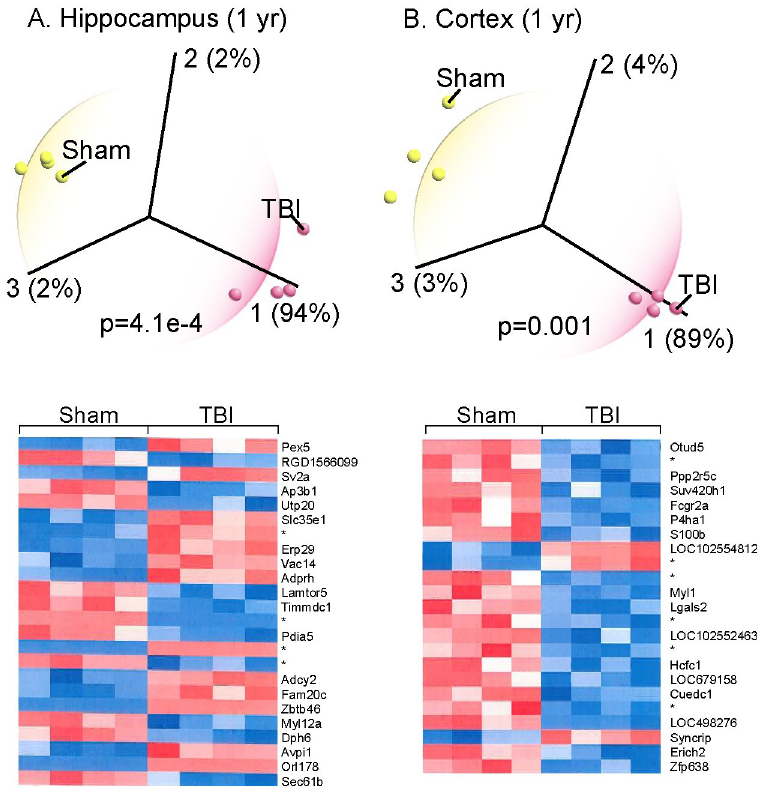
Fig 3. Prinicipal component analysis (PCA) of chronic gene expression one year post-TBI. Qlucore Omics Explorer was used to generate the PCA plots and heatmaps displaying genes that distinguish TBI from sham controls in the hippocampus (A) and cortex (B) at one year post-TBI. Annotated genes are associated with metabolism, synaptic function and proteostasis. Discriminating genes that are significantly differentially expressed but lack annotation (i.e. unknown and uncharacterized) are marked with an asterisk ( � ).